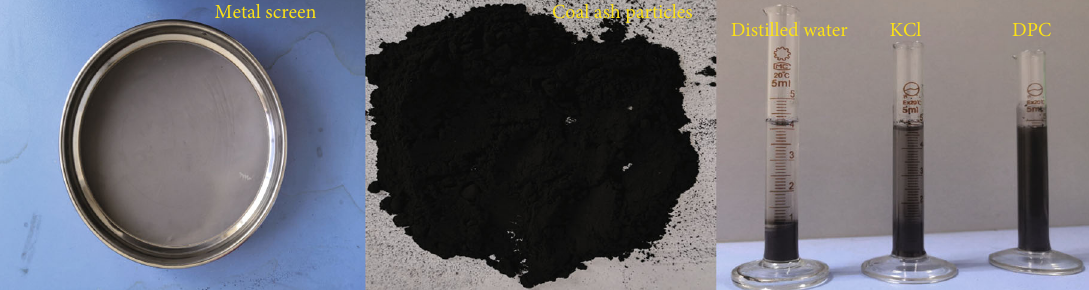
Figure 6: Test on coal ash particle expansion with di ff erent fl